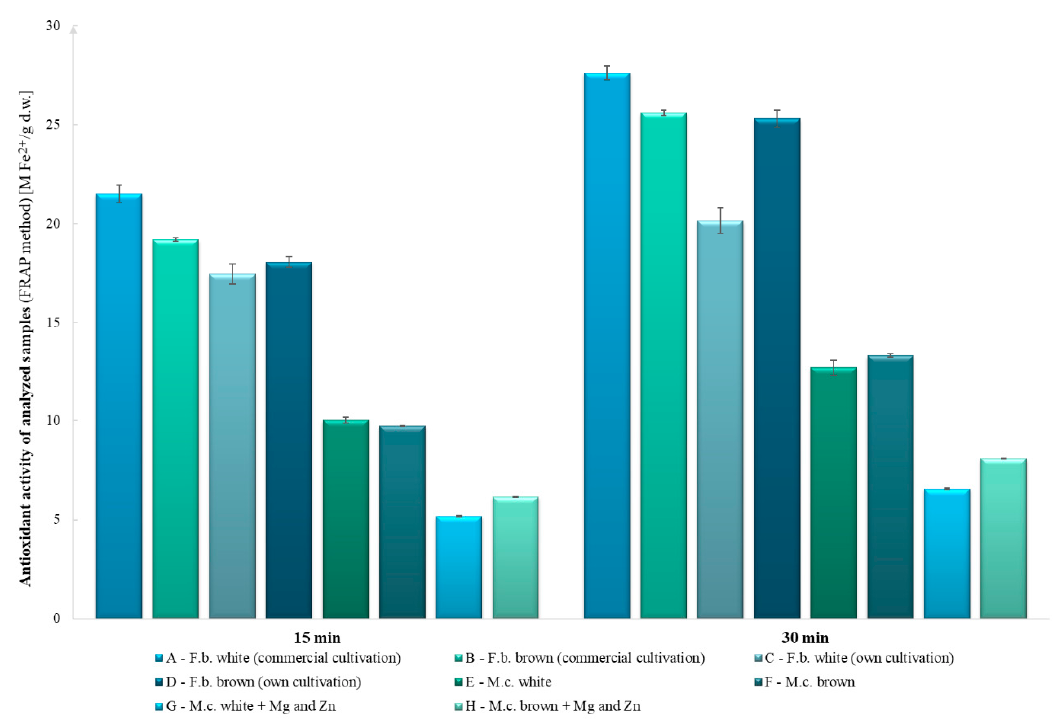
Figure 2. Comparison of antioxidant activity using the FRAP method (after 15 and 30 min).